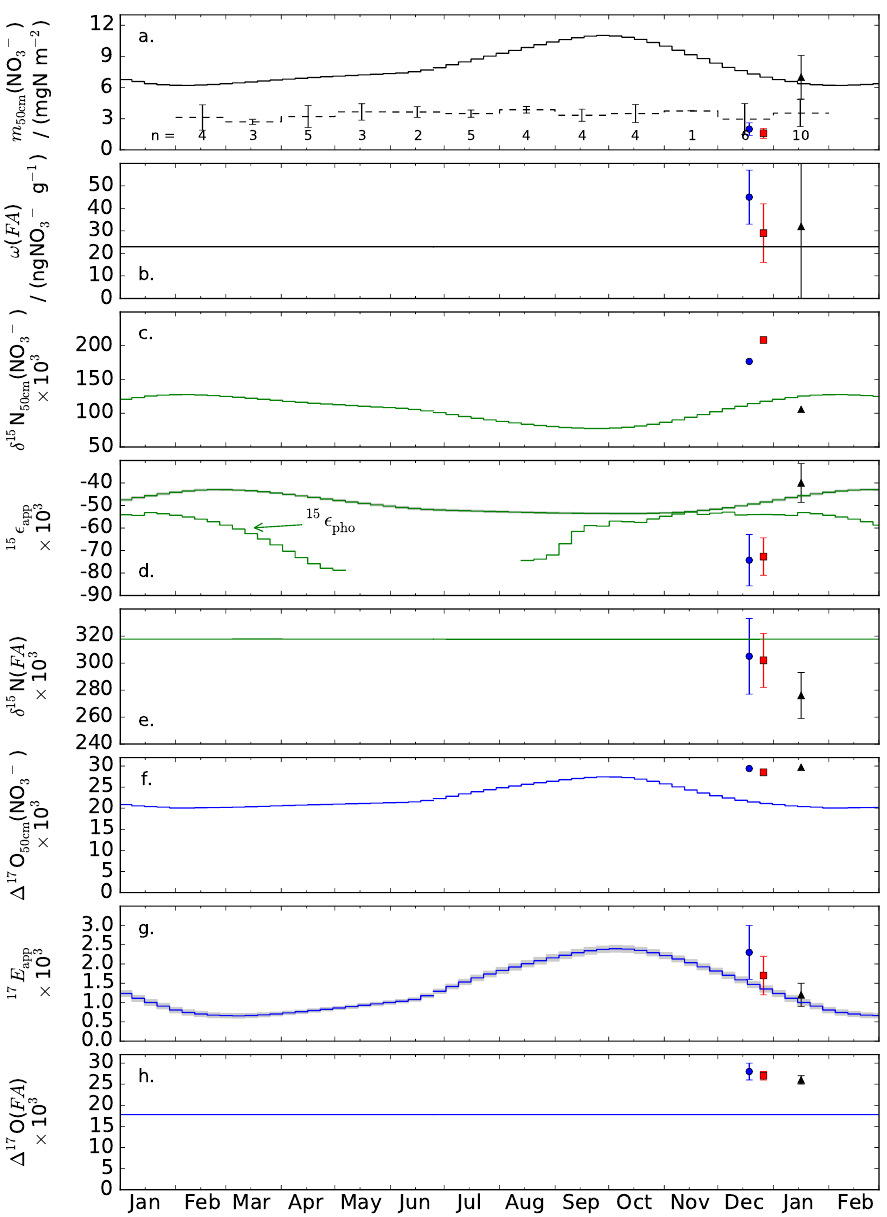
Figure 5. Realistic simulation results for the snowpack and comparison to the observations at Dome C. (a) Nitrate mass in the top 5cm (the dashed curve represents the observed monthly values), (b) archived nitrate mass fractions, (c) δ 15 N of nitrate in the top 5cm, (d) apparent and photolytic 15 ε fractionation constants (in grey, the range ± 1 σ) , (e) δ 15 N in the archived nitrate, (f) (cid:49) 17 O of nitrate in the top 5cm, (g) apparent 17 E fractionation constant (in grey, the range ± 1 σ) and (h) (cid:49) 17 O in the archived nitrate. In each panel, the observed data from the three DC snow pits (Frey et al., 2009; Erbland et al., 2013) are represented by the same symbols as in Fig.